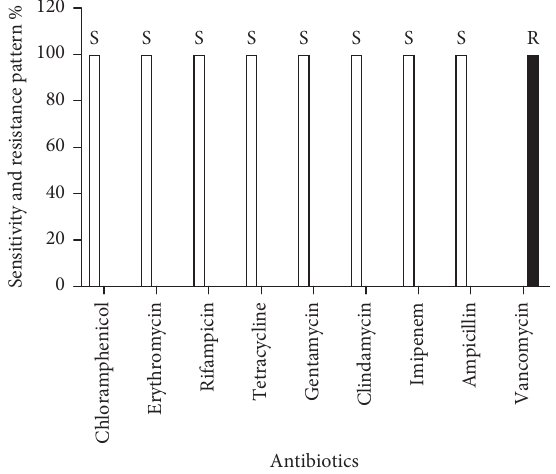
Figure 3: Antibiotic resistance of the selected L . plantarum strains. S represents susceptible; R represents resistance. Table 5: Summary of the assembly and annotation statistics of three L . plantarum